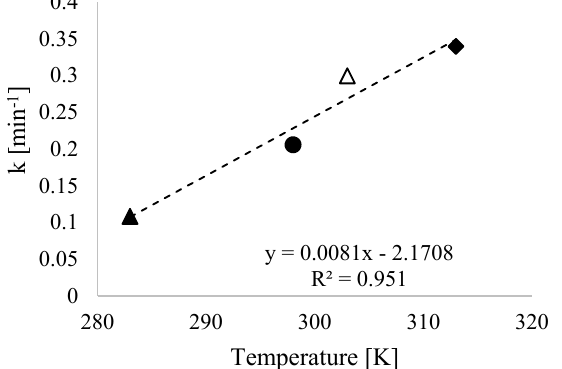
Figure 9. First-order kinetic constants at different temperature conditions: 283 ( ▲ ), 298 ( ● ), 303 ( Δ ), and 313 K ( ♦ ). Condition: unbuffered pH, 0.1 g L − 1 bimetallic nanoparticles, and [NO 3 − ] = 300 mg L − 1 .